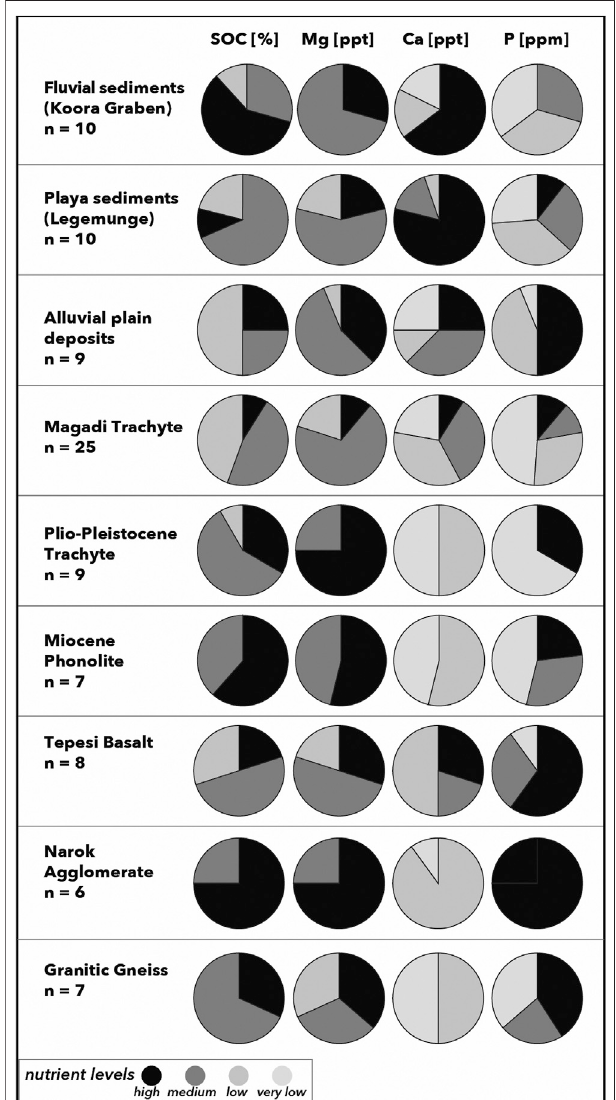
FIGURE 6 | Distributions of soil nutrient levels and SOC attributed to the main lithological and sedimentological units of the study area; SOC: low < 1%, moderate < 2%, high > 2%; Mg: low < 0.25 ppt, moderate 0.25 – 0.6 ppt, high > 0.6 ppt; Ca: very low < 1 ppt, low 1 – 3 ppt, moderate > 3 – 10 ppt,